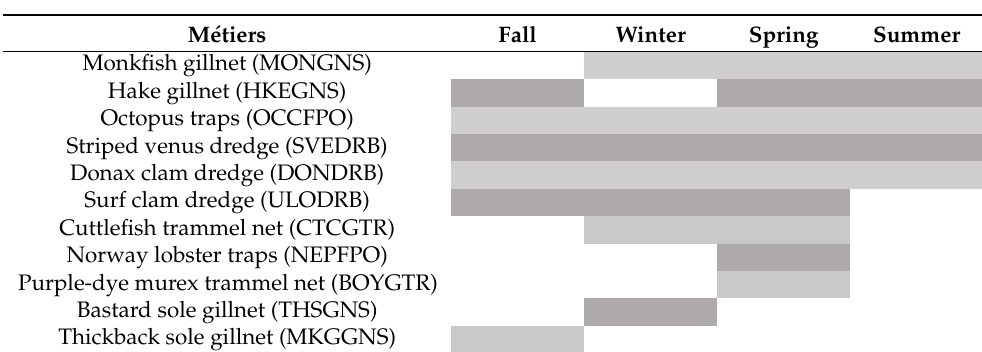
Table 4. M é tiers proposed including the main species, the gear type and the season in which they are